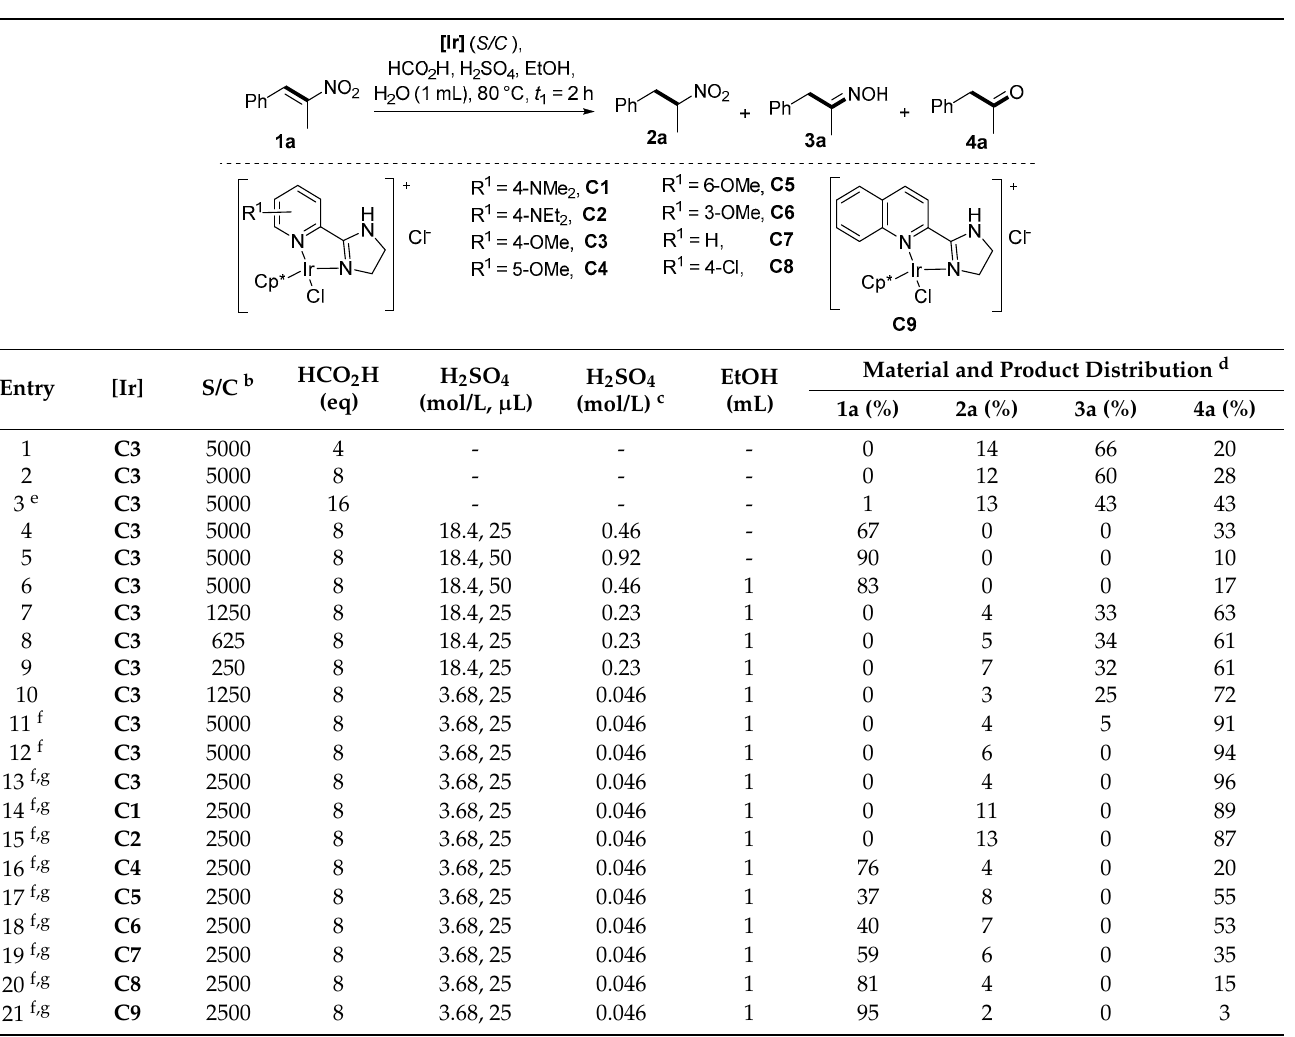
Calculated concentration in the reaction mixture. d Determined by 1 H NMR spectra of crude reaction mixtures. e t 1 = 4 h. f Upon completion of the reduction, 1 mL of concentrated HCl was added and the mixture was treated for 15 min (entry 11), 30 min (entry 12), or 60 min (entries 13– 21). g t 1 = 3 h.